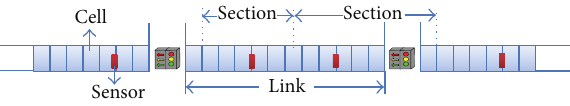
Figure 5: Partitioned arterial